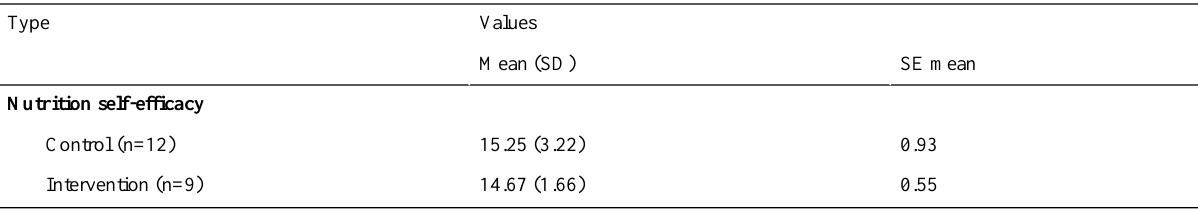
Table 7. Nutrition self-efficacy descriptive statistics.